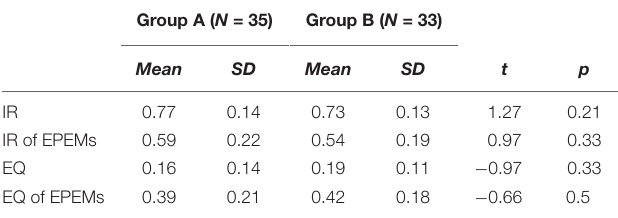
TABLE 4 | Comparisons between two groups in IR and EQ.